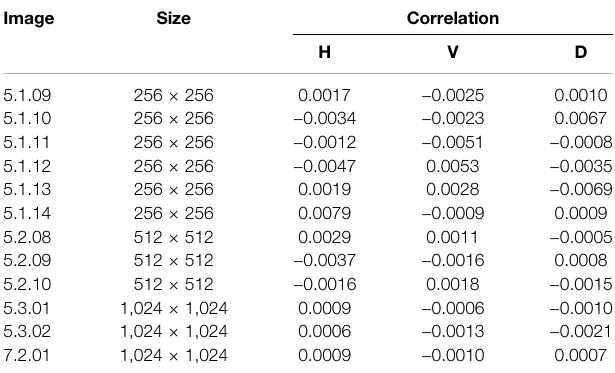
TABLE 7 | Information entropy (IE) and local entropy (LSE) with different